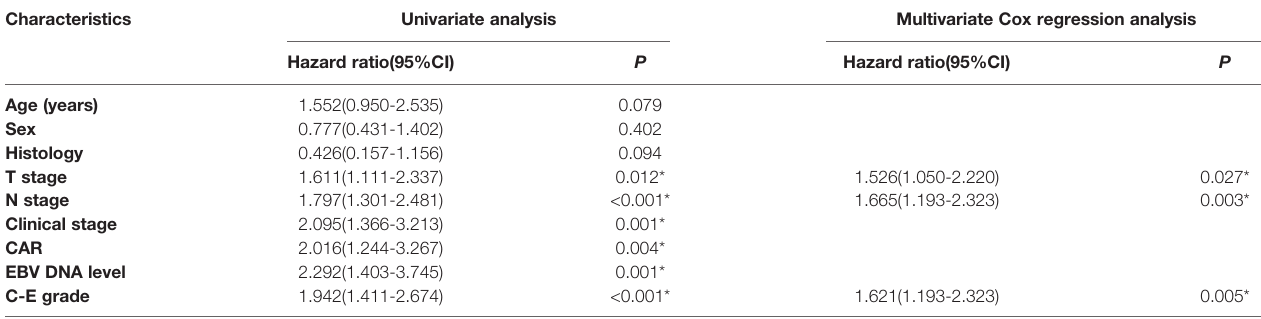
TABLE 3 | Univariate and multivariate analyses of overall survival in the whole cohort. Characteristics